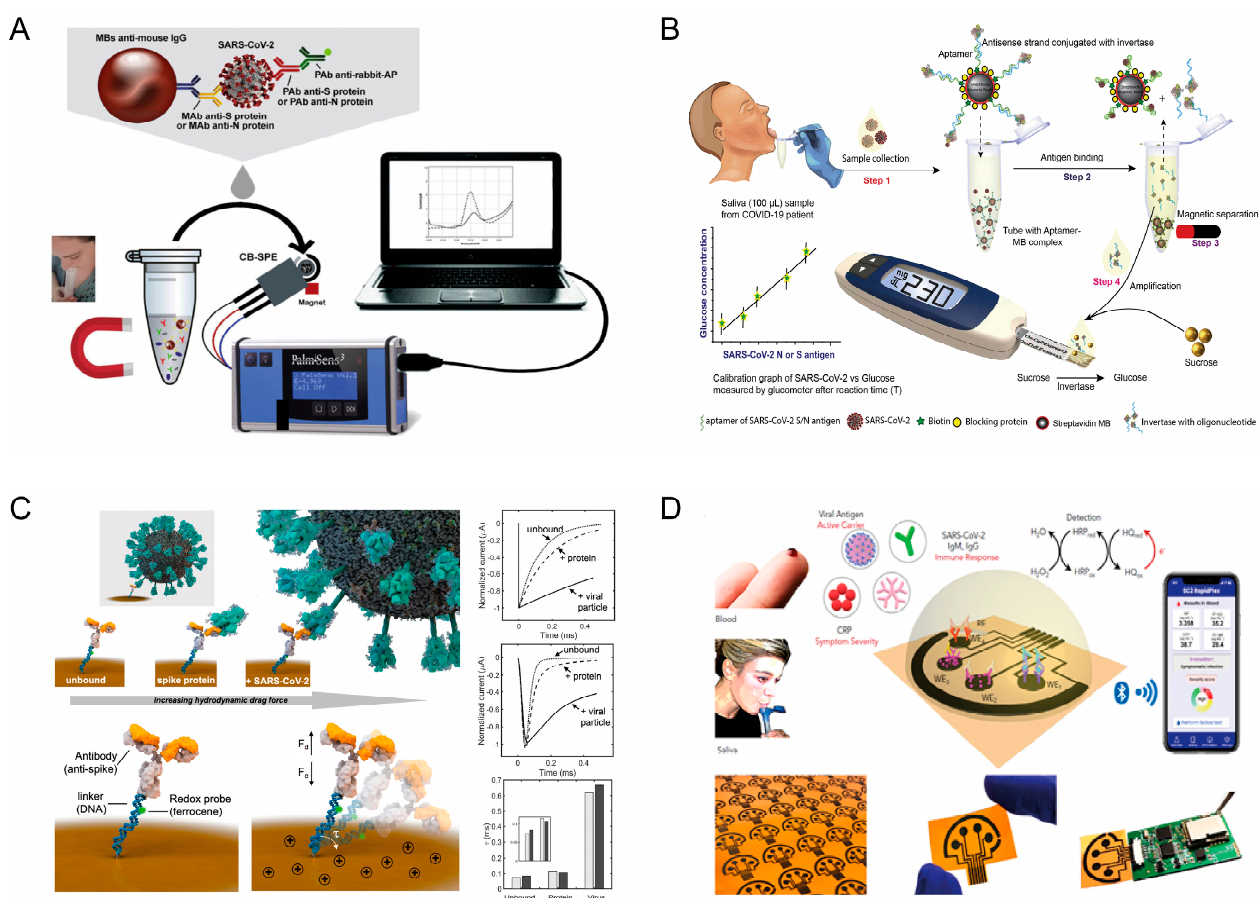
Figure 4. SARS-CoV-2 antigen detection in saliva: ( A ) magnetic beads combined with a nanomaterial-based-printed electrode for the development of two immunosensors for the detection of S and N proteins. Reprinted with permission from [38], 2021 Elsevier; ( B ) magnetic beads for the development of a cheap aptamer assay for the detection of S and N protein antigens, exploiting an off-the-shelf glucometer. Reprinted with permission from [39], 2021 Elsevier; ( C ) a reagent-free electrochemical immunosensor for directly reading out viral particles in 5 min. Reprinted with permission from [40], 2020 American Chemical Society; ( D ) an electrochemical biosensing system for the detection of N protein, IgM and IgG antibodies, and inflammatory biomarker C-reactive protein using the same hand-held device. Reprinted with permission from [41], 2020 Elsevier.